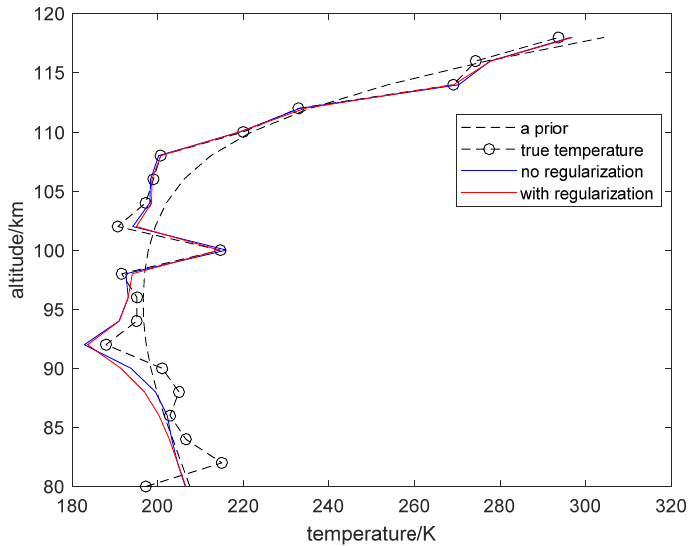
Figure 17. Retrieval of atmospheric temperature in MLT region combined with regularization constraint and without regularization constraint.